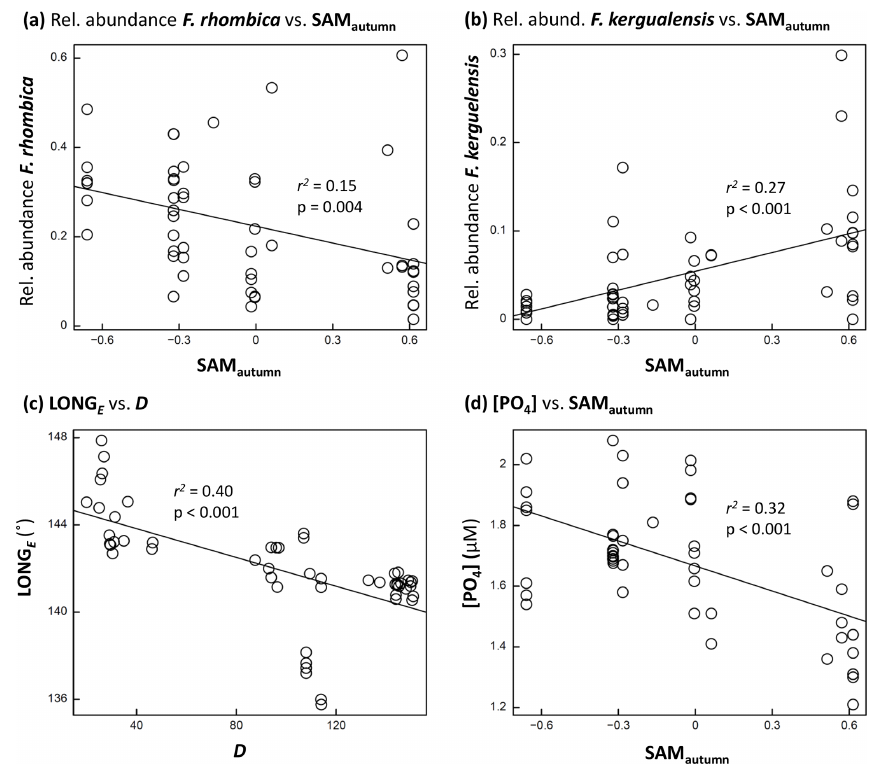
Figure 5. Scatter-plots: (a, b) examples of phytoplankton taxon relative abundance versus SAM autumn ; (c) LONG E of sample collection versus D ; and (d) [PO 4 ] versus SAM autumn . Each figure shows r 2 and p associated with the relationship. A line of least-squares best fit is provided to give an indication of